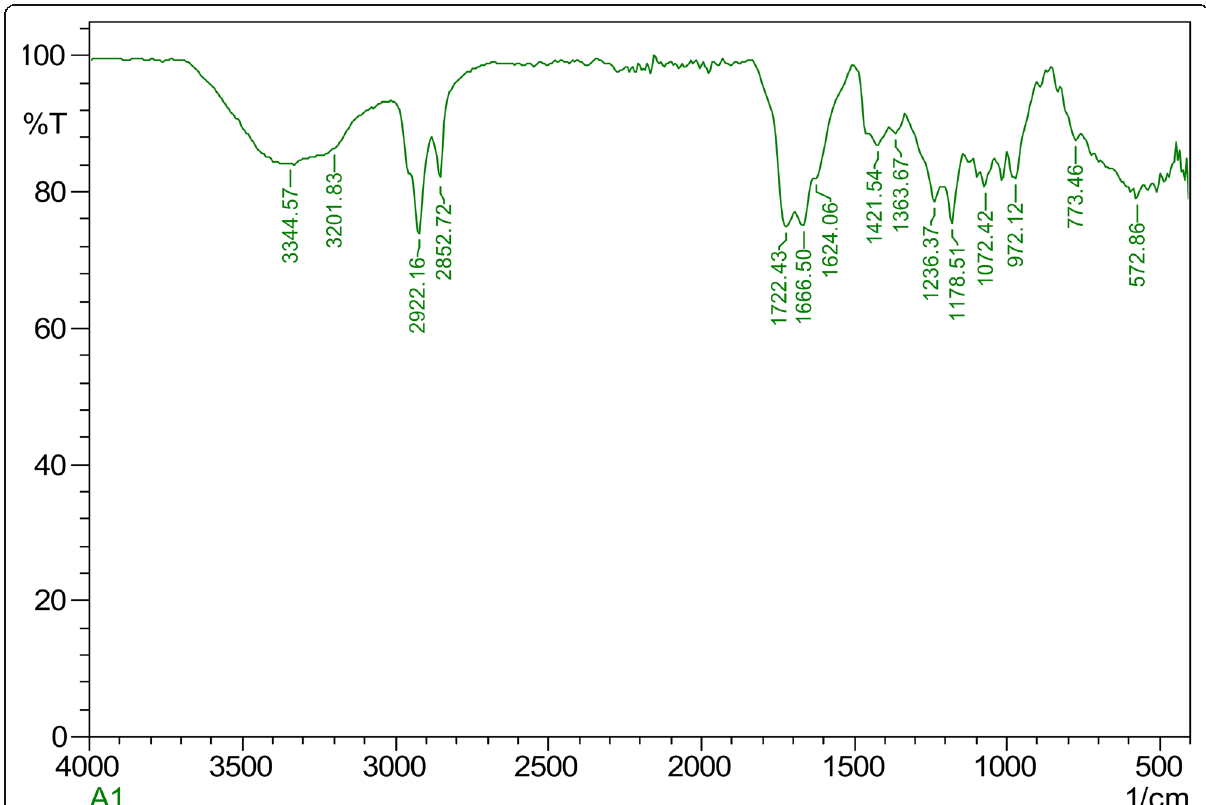
Fig. 2 FTIR results of T. chebula